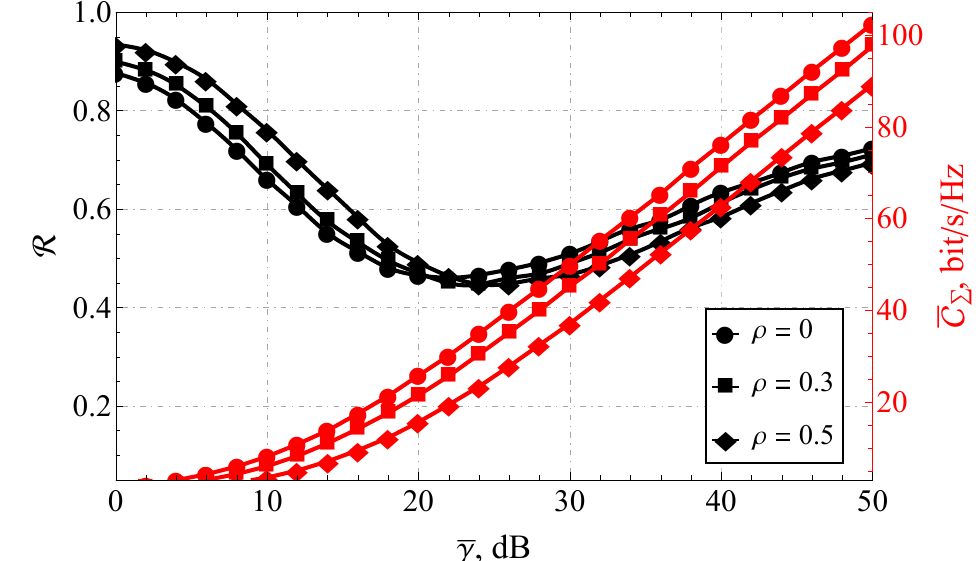
Figure 2. The joint R – C Σ performance of the 8 × 8 for a variable γ